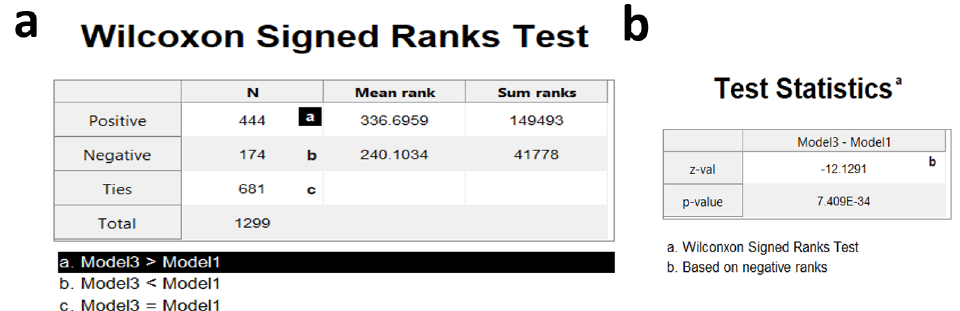
Figure A2. Wilcoxon signed rank test. ( a ) The Wilcoxon signed rank test table shows the difference that exists in 2 related samples through positive, negative and tie ranges. ( b ) p -value obtained with Wilcoxon rank test was 741E-34 less than the significance value of 0.05, so it was concluded that there was a statistically significant difference between both models.